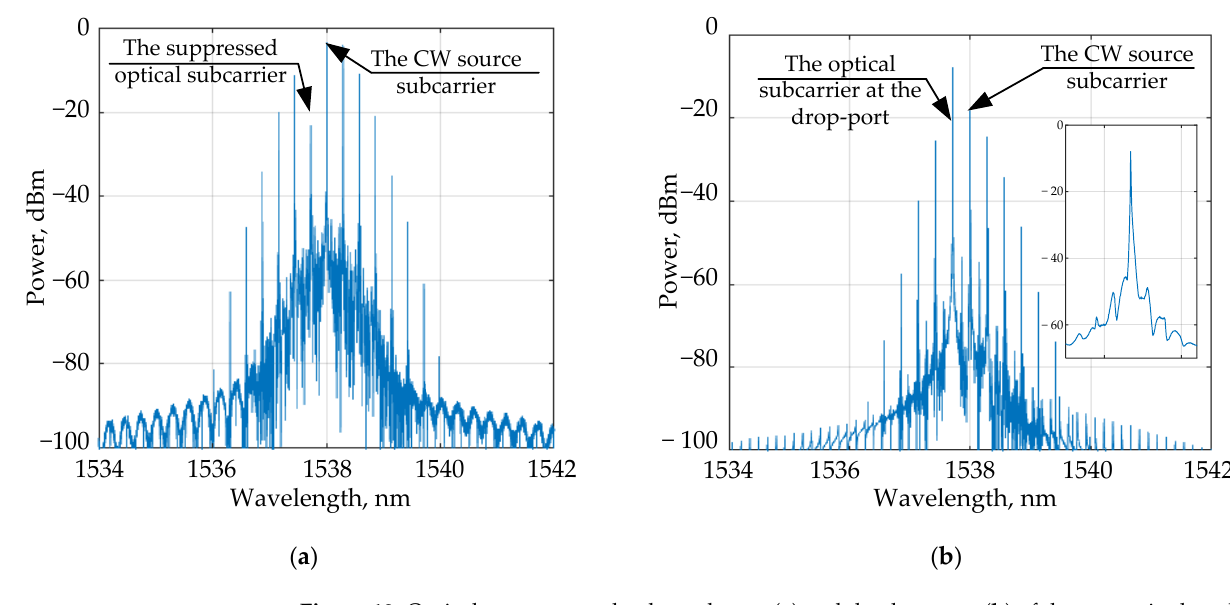
Figure 10. Optical spectrum at the through port ( a ) and the drop port ( b ) of the sensor in the scheme with an OEO. In inset: the magnified spectrum of the optical subcarrier at the drop-port.